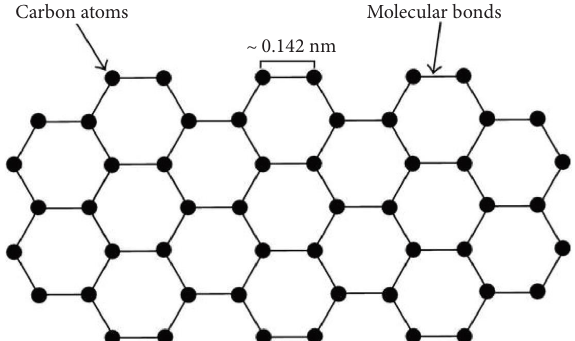
Figure 1: Depiction of a typical sheet of graphene (reprinted from